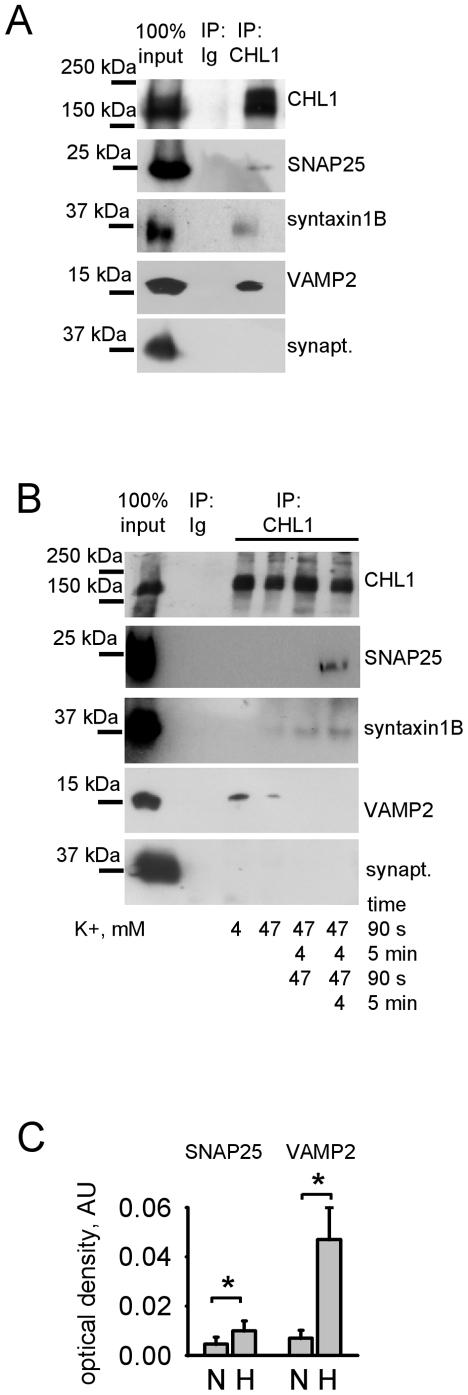
CHL1 interacts with SNARE complex proteins.
A - CHL1 immunoprecipitates (IP) from brain lysates and input material were probed with the indicated antibodies by Western blot. Mock IP with non-specific rabbit immunoglobulins (Ig) was performed for control. SNAP25, syntaxin1B, and VAMP2, but not synaptophysin co-immunoprecipitated with CHL1. B - CHL1 was immunoprecipitated (IP) from synaptosomes that were mock-stimulated with 4 mM K+, or stimulated one or two times with 47 mM K+ for 90 s with or without 5 min recovery in 4 mM K+ after stimulations (as indicated). CHL1 immunoprecipitates and input material were then probed by Western blot with indicated antibodies. Mock IP with non-specific immunoglobulins (Ig) was performed for control. Note that no co-immunoprecipitation of SNAP25 and syntaxin 1B with CHL1 is observed in mock-stimulated synaptosomes even after high exposure of the blots. Stimulation induces co-immunoprecipitation of SNAP25 and syntaxin1B, and decreases levels of co-immunoprecipitated VAMP2. C - CHL1ID (1.9 µM) was immobilized on plastic and assayed by ELISA for the ability to bind SNAP25 (4 µM) and VAMP2 (6 µM) either in native form (N) or after exposure to 42°C (H). CHL1ID binds stronger to non-native SNAP25 and VAMP2. *p<0.05, paired t-test (n = 6).